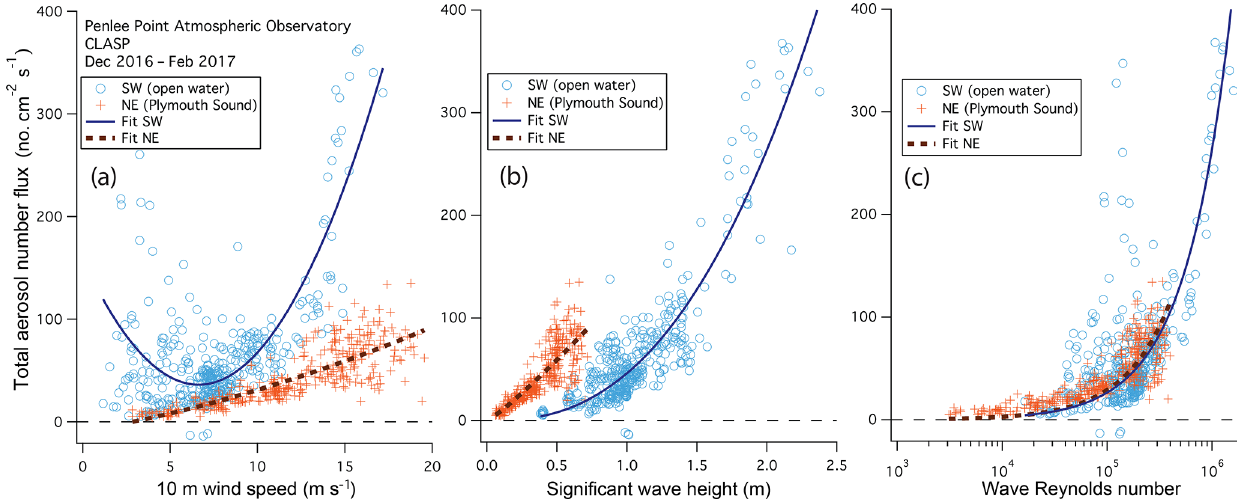
Figure 8. Total aerosol number net flux from the CLASP (December 2016–February 2017) vs. wind speed (a) , significant wave height (b) , and wave Reynolds number (c) . Data are separated into two distinct wind sectors: the southwest sector that faces the open water and the northeast sector that faces the Plymouth Sound (fetch of ∼ 5km). Power fits of aerosol fluxes to H s and linear fits to R H